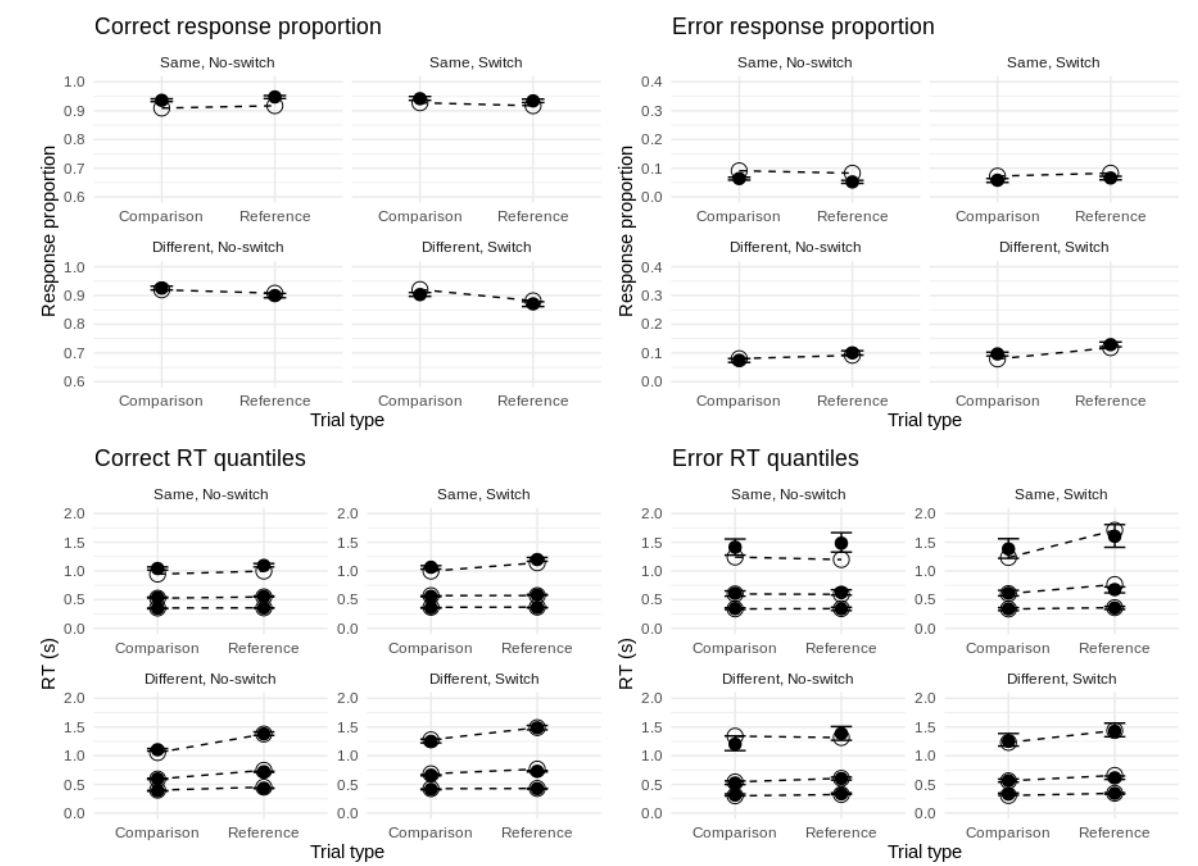
Figure 5. Fits of top model to behavioral data. Top panels: Fits to correct and error proportions. Bottom panels: Fits to the 0.1, 0.5, and 0.9 quantiles of correct and error RT distributions. Unfilled circles represent data effects. Filled circles represent posterior model predictions with 95% credible intervals.